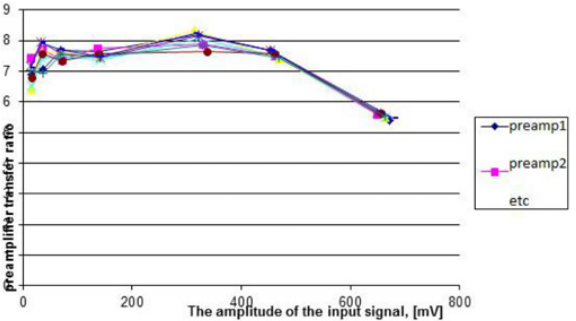
Figure 5. Preamplifiers transition ratio as a function of input signal voltage.